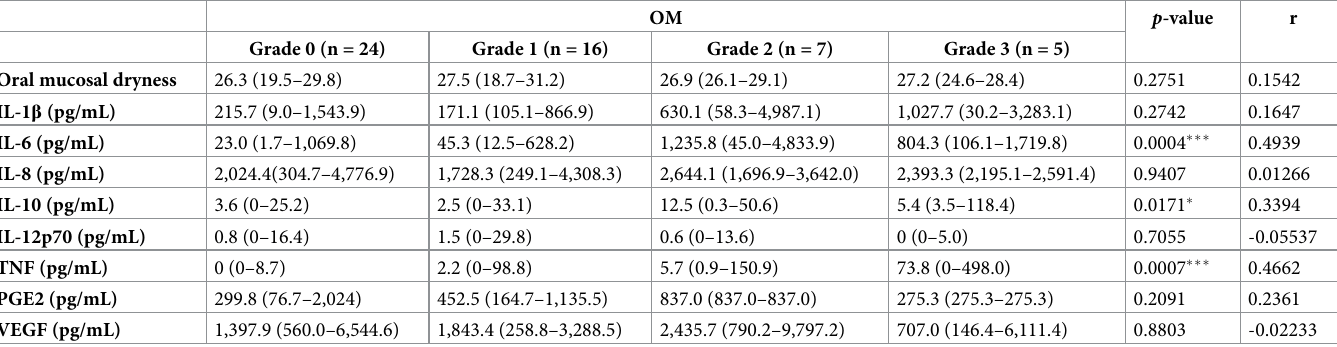
Table 4. Correlation between the oral mucositis grade and the measurements.